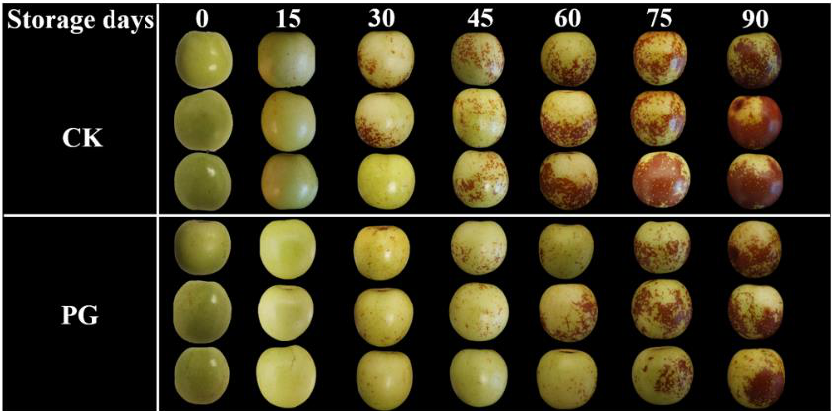
Figure 1. Effects of PG treatment on the visual appearance of winter jujube fruits.